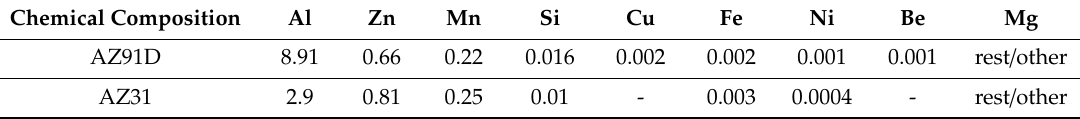
Table 1. The chemical composition (wt%) of the tested workpiece magnesium alloys. Chemical Composition